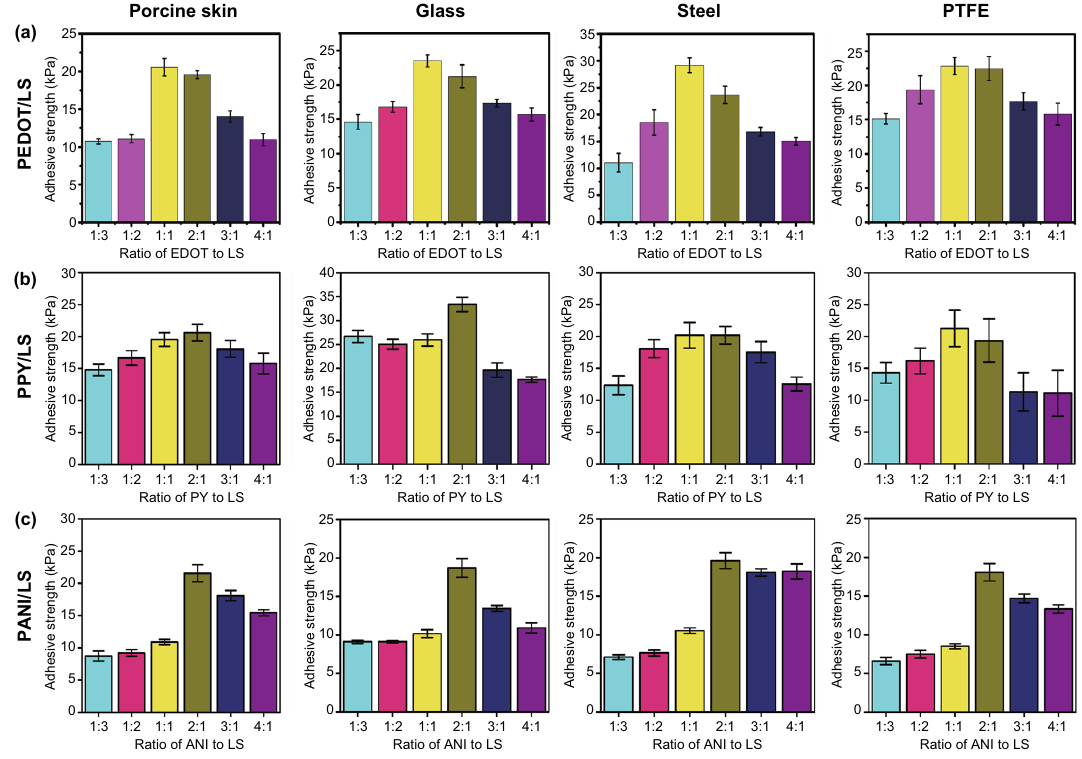
Fig. 4 The effect of the mass ratio of CP to LS of the CP/LS NPs on the adhesive strength of the NPs-incorporated hydrogels a PEDOT/LS, b PPY/LS, and c PANI/LS. The content of the CP/LS NPs was 3 wt